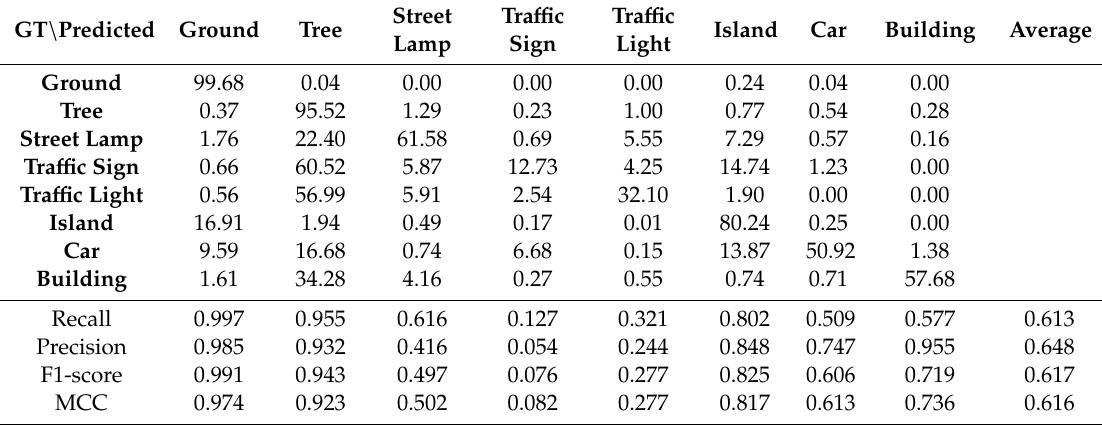
Table 11. Normalized Confusion matrix of MLS_PointNet_1.